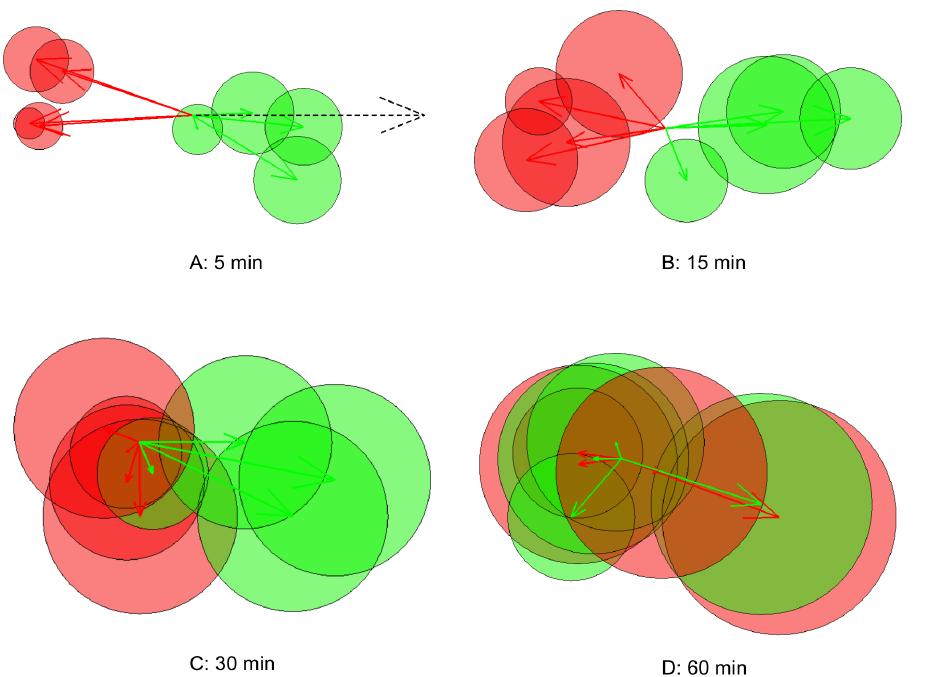
Figure 2. Mean vectors of posterior turning-angle distributions. Mean vectors are represented for subsampling intervals of 5, 15, 30 and 60 min, for both behavioural modes (red is State 1, green is State 2), for each of the four possums. Each arrow and circle represents one behavioural mode for one possums. Circles around arrow heads have radii equal to the posterior standard deviation of mean vectors. The dashed arrow in (a) is of length 0.4 (the maximum possible length for a mean vector is 1, which corresponds to a point distribution).